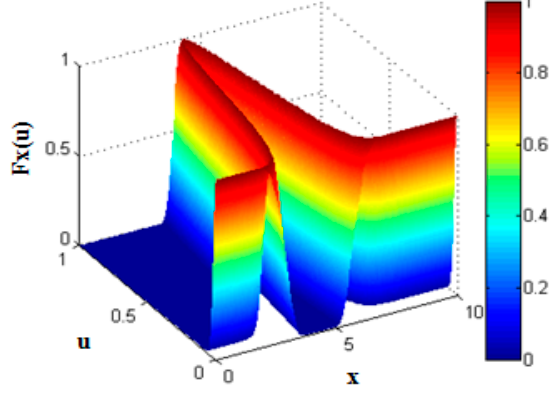
Figure 2. GT2 membership function representation .